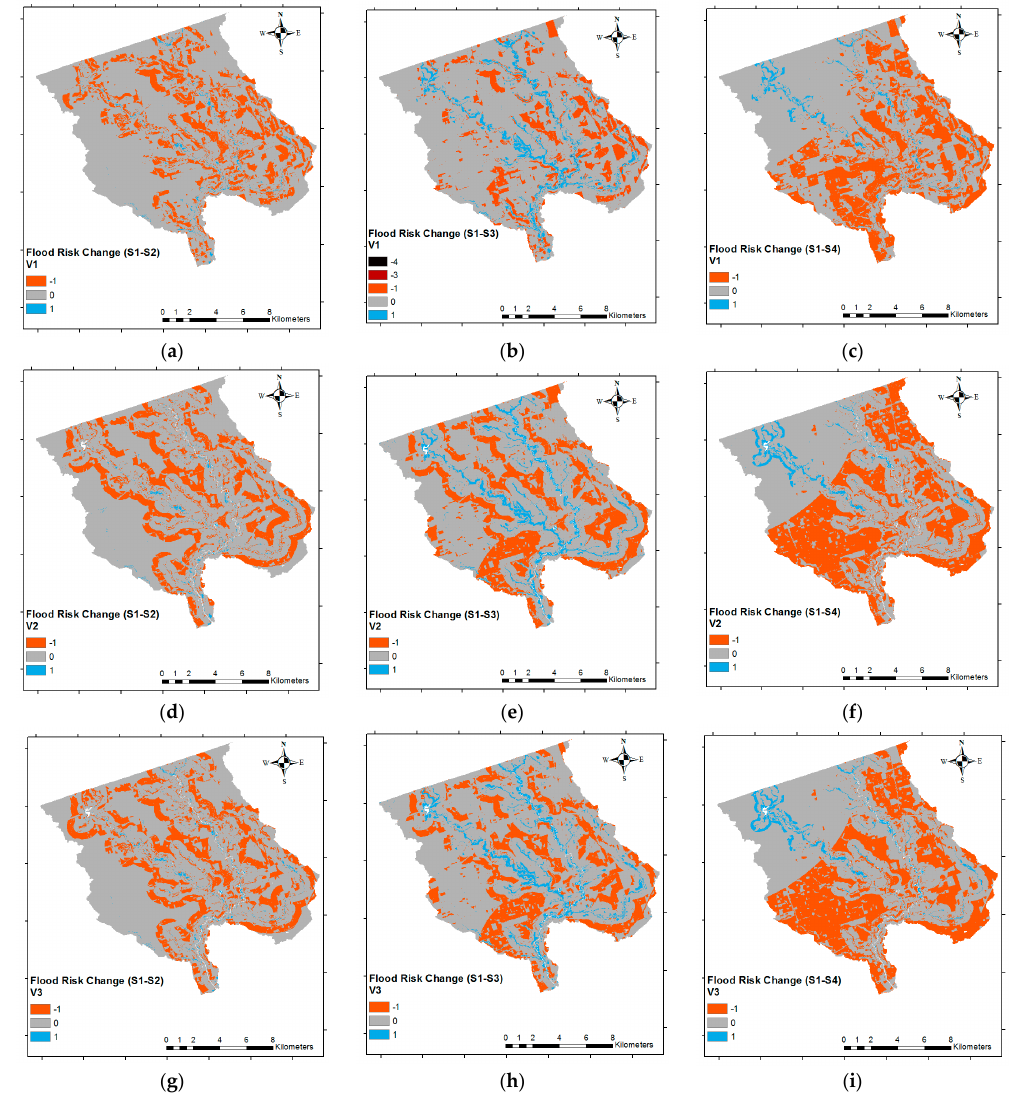
Figure A1. Flood risk change maps; ( a ) S2_V1; ( b ) S3_V1; ( c ) S4_V1; ( d ) S2_V2; ( e ) S3_V2; ( f ) S4_V2; ( g ) S2_V3; ( h ) S3_V3; ( i ) S4_V3.